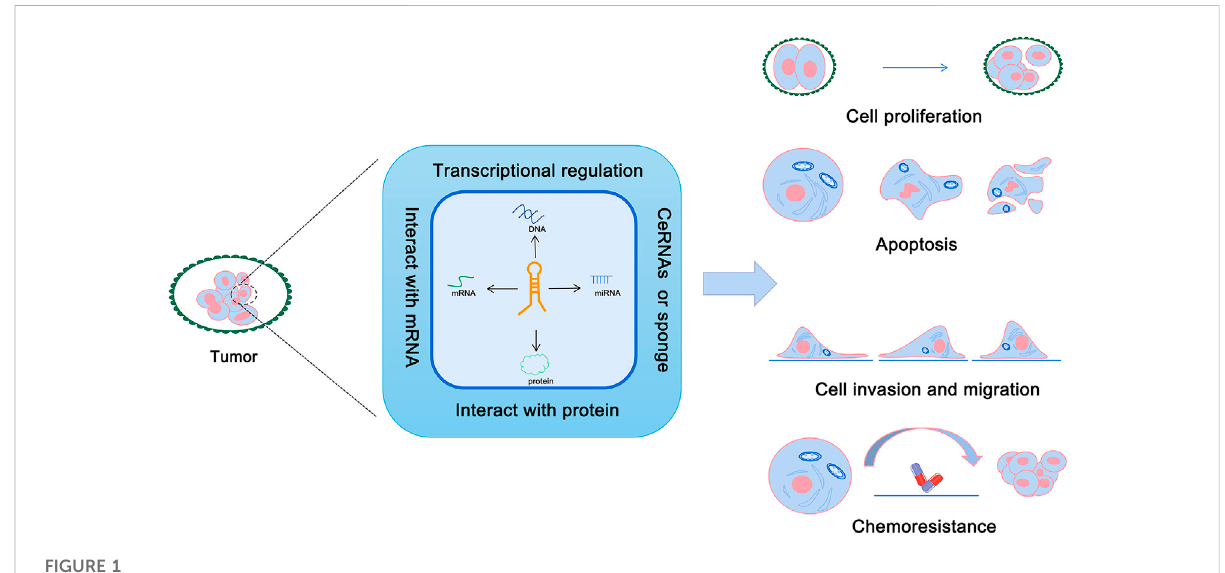
FIGURE 1 Roles of lncRNAs in